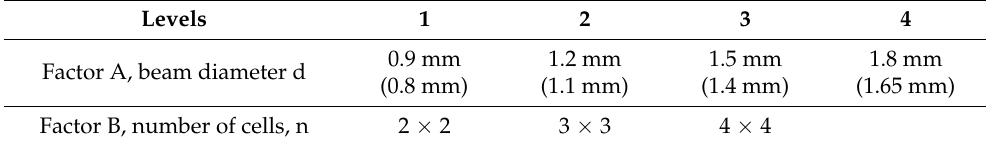
Table 1. Factors A and B and the levels considered for assessing the influence of the cell parameters on the absorbing capabilities of the investigated